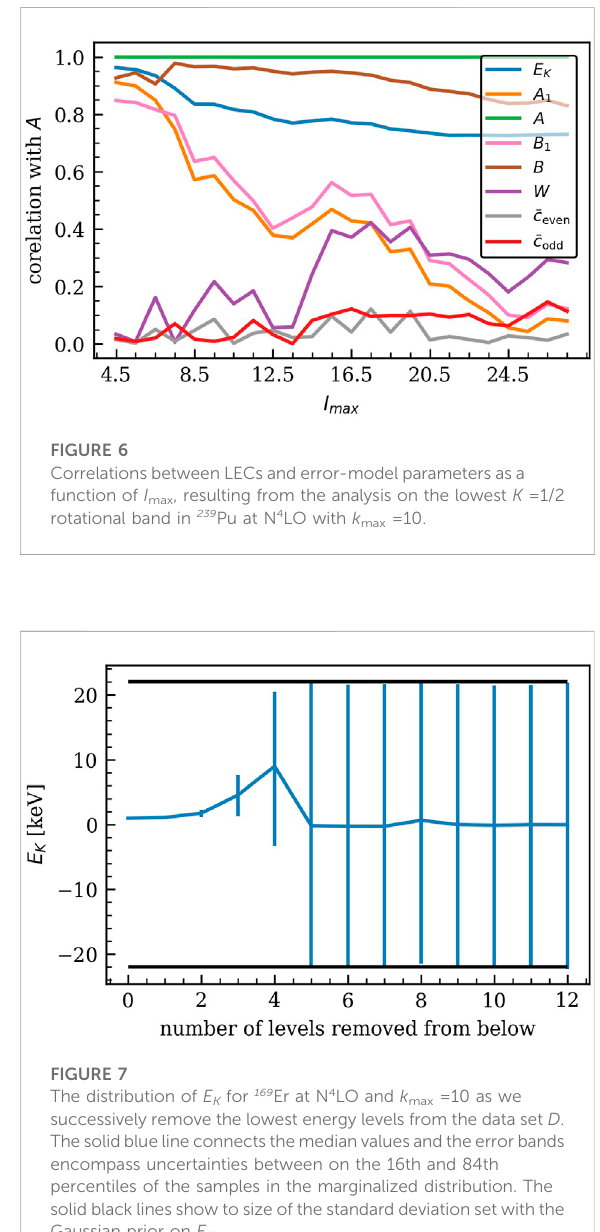
credible intervals, shown as error bars in the fi gure. Adding more